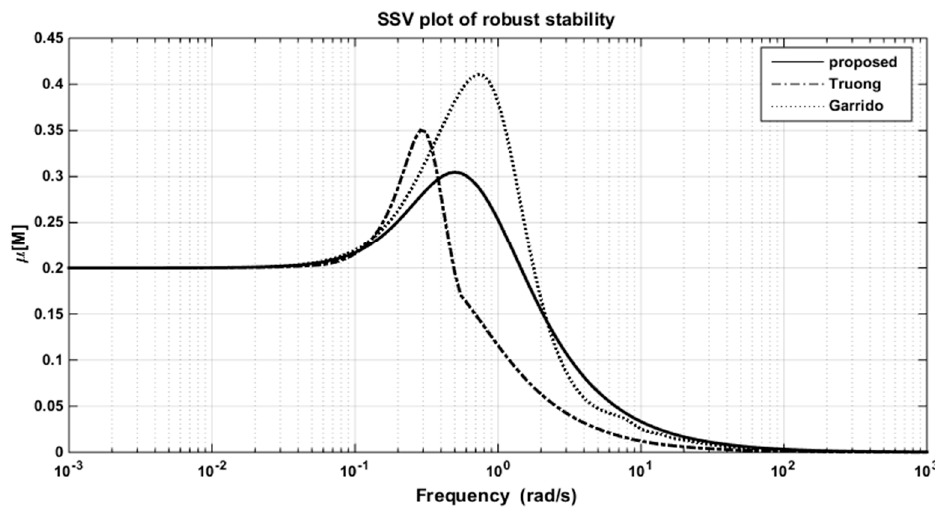
Figure 17. The SSV plots for robust stability in the VL column. Table 8. Robustness analysis for the VL column under ± 20% parametric uncertainty in all parameters.